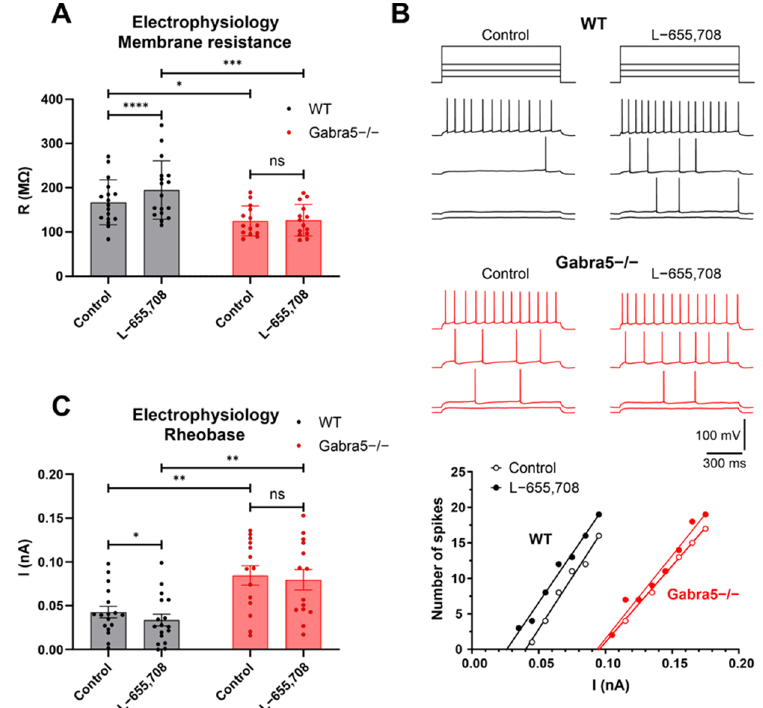
Figure 6. Deletion of Gabra5 reduces neuronal excitability in CA1 hippocampal slices. ( A ) Comparison of membrane resistance (R) of CA1 pyramidal neurons from WT and Gabra5 − / − mice in the absence or presence of L-655,708. Lower R values indicate reduced neuronal excitability in Gabra5 − / − mice. L-655,708, an inverse agonist of GABA(A) receptors containing the α 5 subunit, signi fi cantly reduced membrane resistance of neurons in WT but not in Gabra5 − / − mice. Values are mean ± SEM of 17 (WT) and 14 ( Gabra5 − / − ) experiments. **** p < 0.0001; two-way RM ANOVA followed by Sidak’s multiple comparisons test was used to compare R values for the same neurons in the absence (Con- trol) and presence of L-655,708. *** p < 0.05, * p < 0.05; Two-way ANOVA followed by Sidak’s multiple comparisons test was used to compare R values in WT and Gabra5 − / − neurons. ( B ) Example traces showing voltage responses of WT (black) and Gabra5 − / − (red) pyramidal neurons evoked by current step stimulations (shown above the traces) of amplitude 25, 35, 45 and 85 pA (WT) or 95, 105, 115